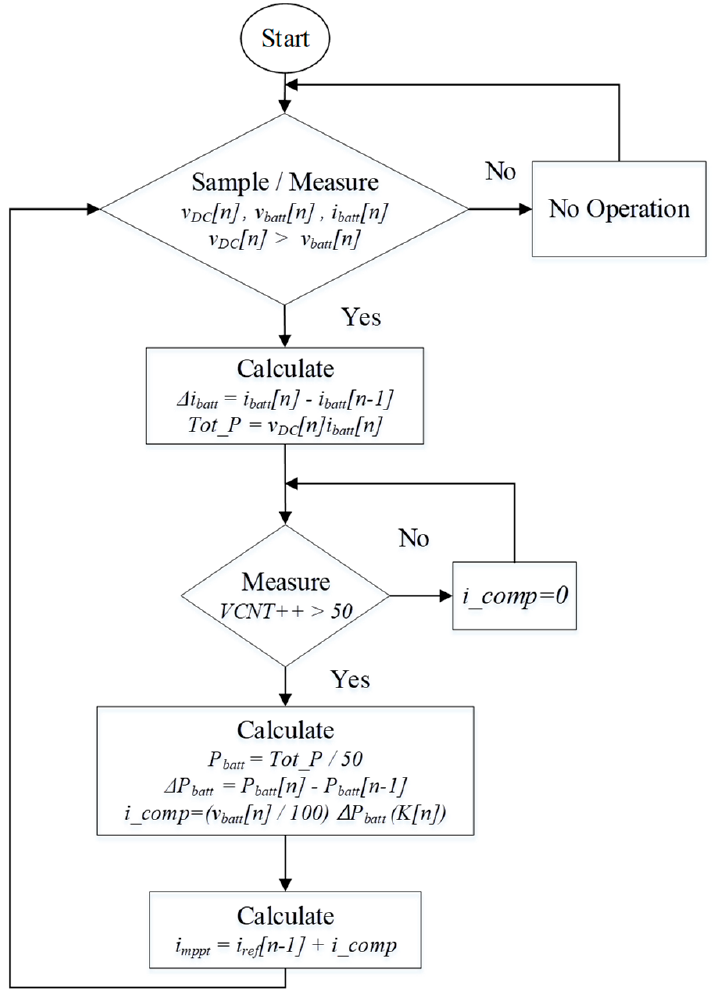
Figure 3. Flow chart of P&O MPPT algorithm.